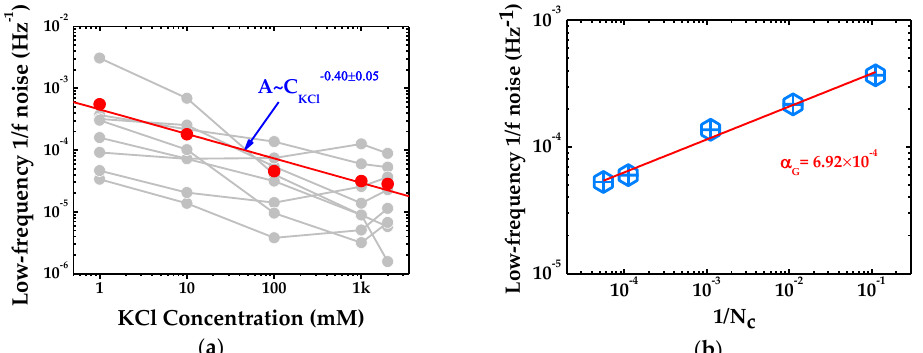
Figure 3. Verification of Hooge’s relation in single-layer graphene based nanopore system: ( a ) Dependency of low-frequency noise on KCl concentration. The red points are the average of eight pores at varied KCl concentration. Likewise, the red curve is the linear fitting of the mean values at different KCl concentration; and ( b ) the relationship between low-frequency noise and inverse number of charge carriers. The fit line determines the noise coefficient ( α G ) in the graphene nanopore of No.